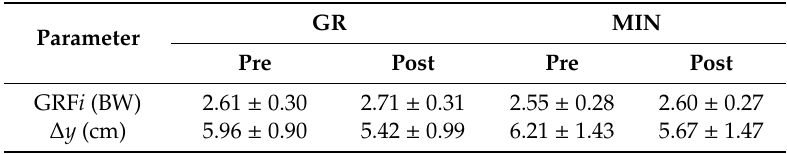
Figure 7. Comparison of lower limbs sti ff ness between two groups before and after training. * significant di ff erence from pre- to post-tests. Table 5. Vertical GRF when the center of gravity (CoG) was lowest, and the vertical displacement of CoG. GRFi represents the vertical GRF when the CoG was lowest, and ∆ y represents the vertical displacement of CoG during